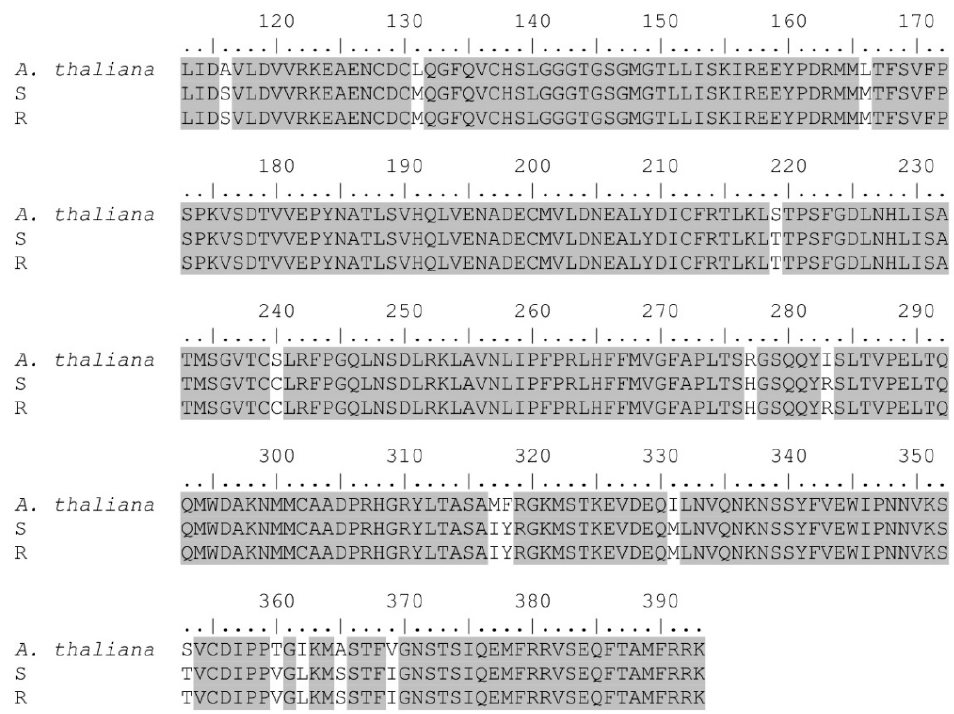
Figure 4. Partial protein sequence alignment of β - tubulin gene of trifluralin-susceptible (S) and resistant (R) A. palmeri accessions. Sequences were aligned to that of the A. thaliana (AT1G75780) β - tubulin gene. Highlighted color indicates homology among the different sequences.